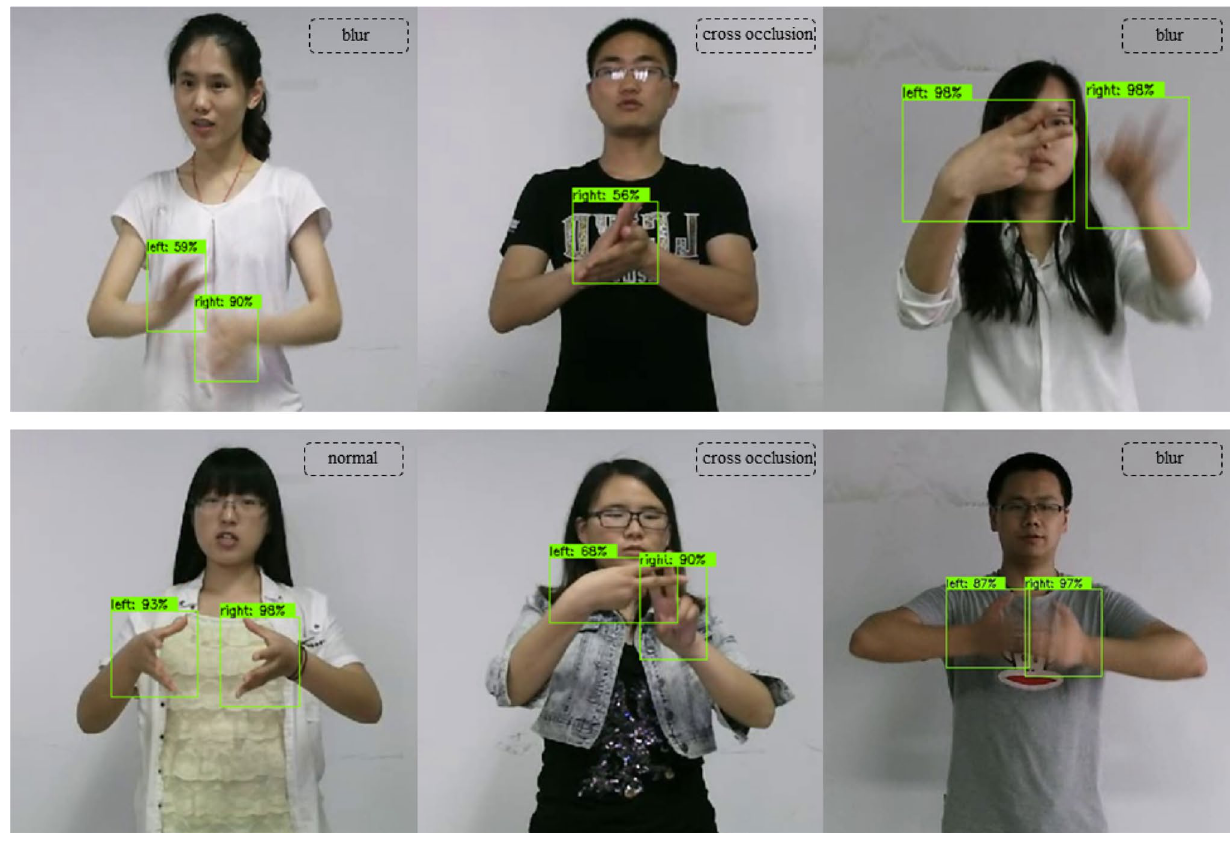
Figure 17. The hand detection effect of this